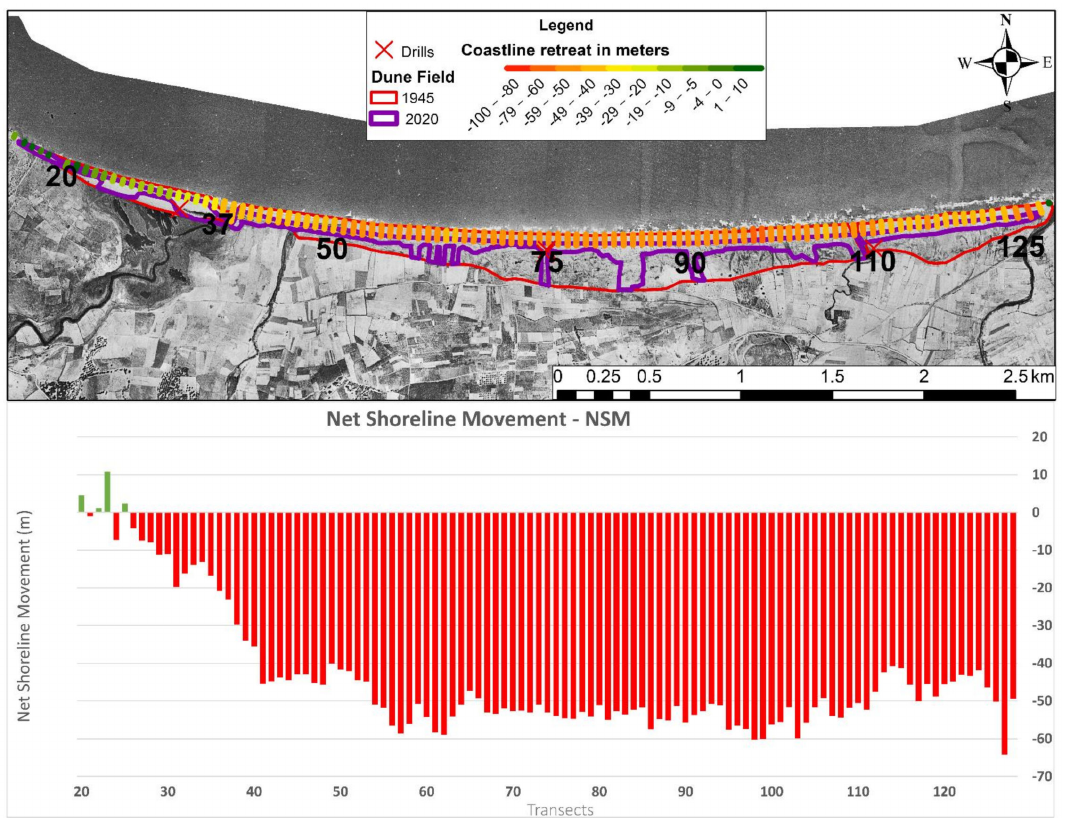
Figure 5. Coastal retreat in meters during the period 1945–2020. Location of the research cores and the selected transects of Table 2. Expansion of the dune filed for the years 1945 and 2020 (above image). Net shoreline movements in meters per transect based on the DSAS